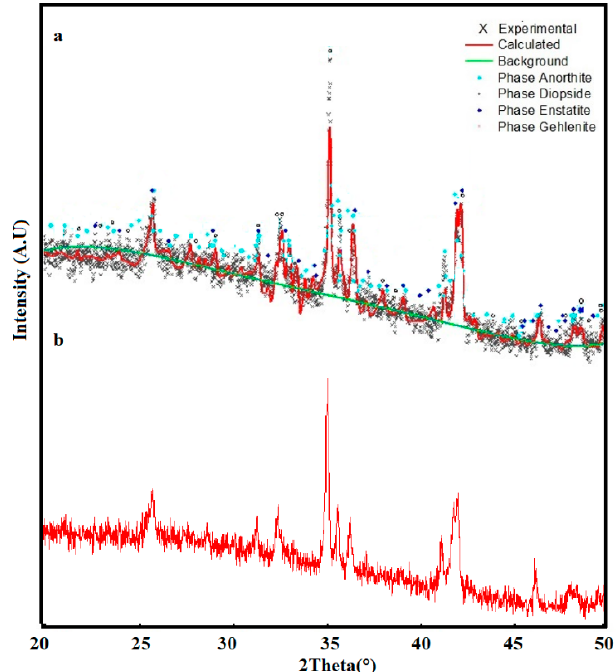
Figure 12. X-ray diffraction patterns: (a) Mixture 2 at 1200 °C with the annealing process at 930 °C and 1100 °C for 2 h; (b) Mixture 2 at 1200 °C.